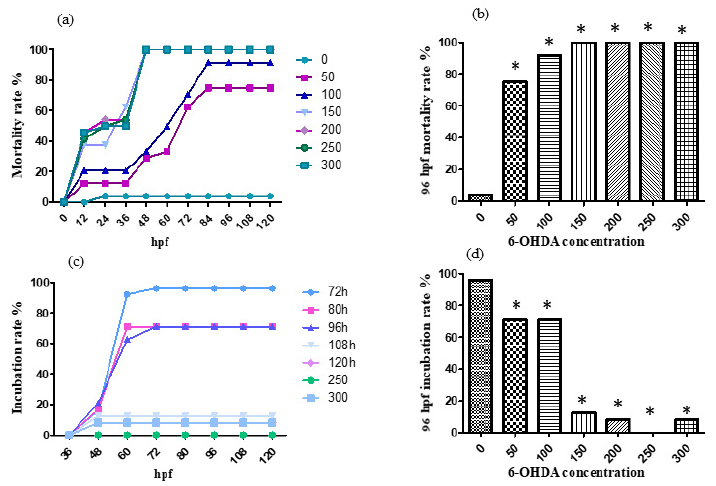
Figure 4. The mortality rate ( a , b ) and incubation rate ( c , d ) after being 6-OHDA-treated (at a high concentration). The results were analyzed by χ 2 test, vs. the control group (0 µ L/mL ethanol): * p < 0.05.